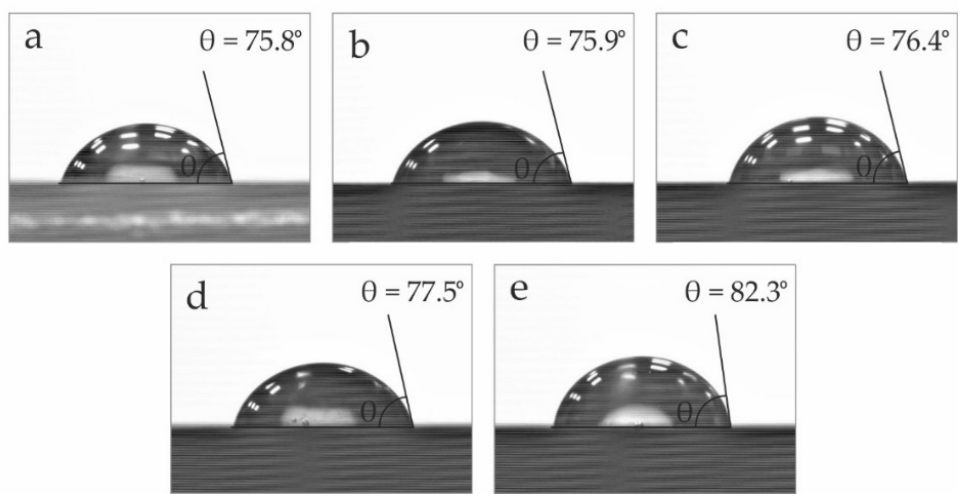
Figure 7. Water contact angles of the different composites: ( a ) PA1010; ( b ) PA1010/2.5EGr; ( c ) PA1010/5EGr; ( d ) PA1010/7.5EGr; ( e ) PA1010/10EGr.